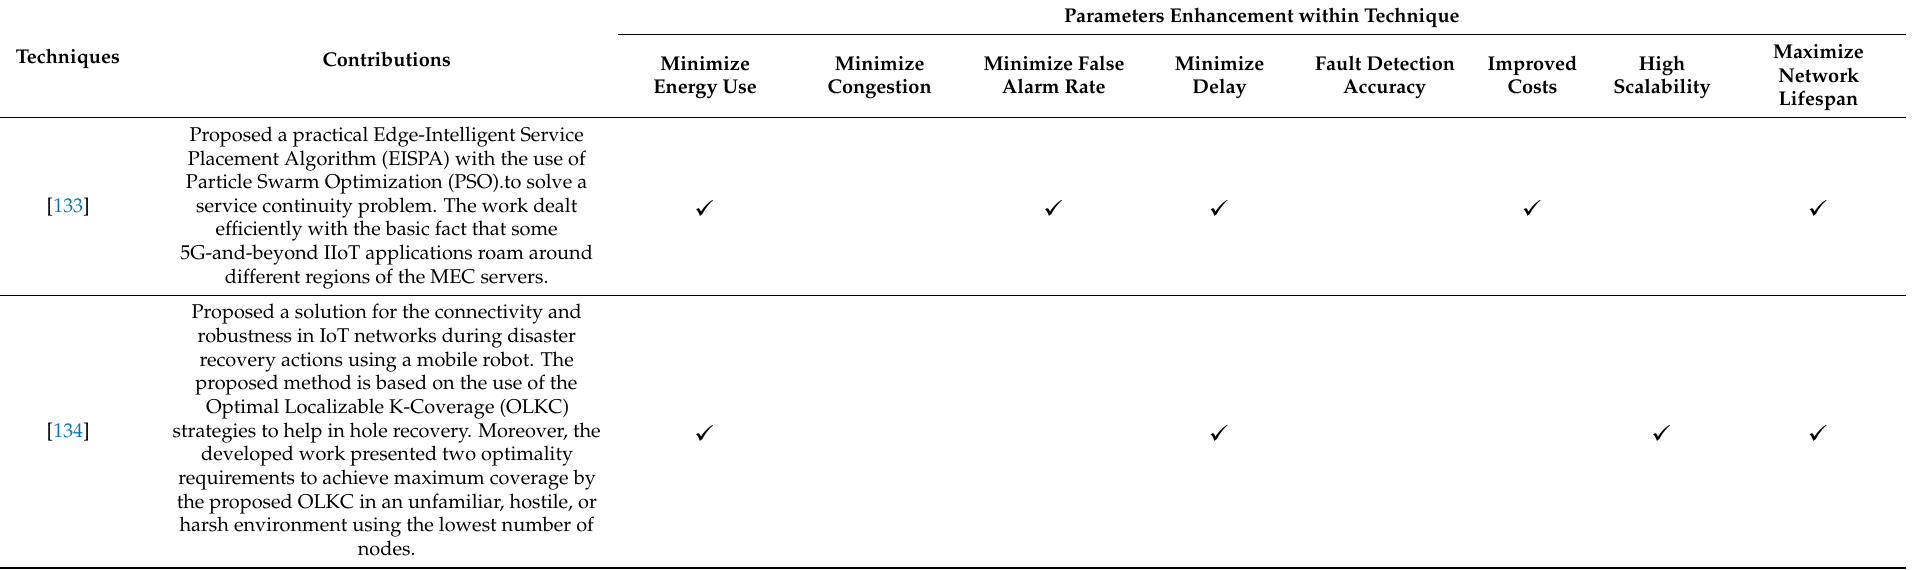
Table A1. Cont. Table 1. Surveys on Fault-Tolerant in WSNs. Table 1. Surveys on Fault-Tolerant in WSNs. Table 1. Surveys on Fault-Tolerant in WSNs. Table 1. Surveys on Fault-Tolerant in WSNs. Table 1. Surveys on Fault-Tolerant in WSNs.